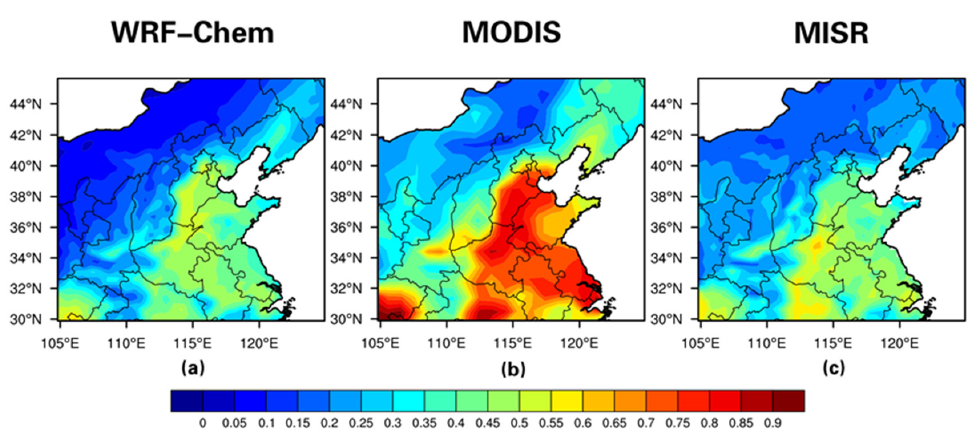
Figure 2. Averaged AOD in 2000–2005 derived from model ( a ), MODIS ( b ), and MISR ( c ).